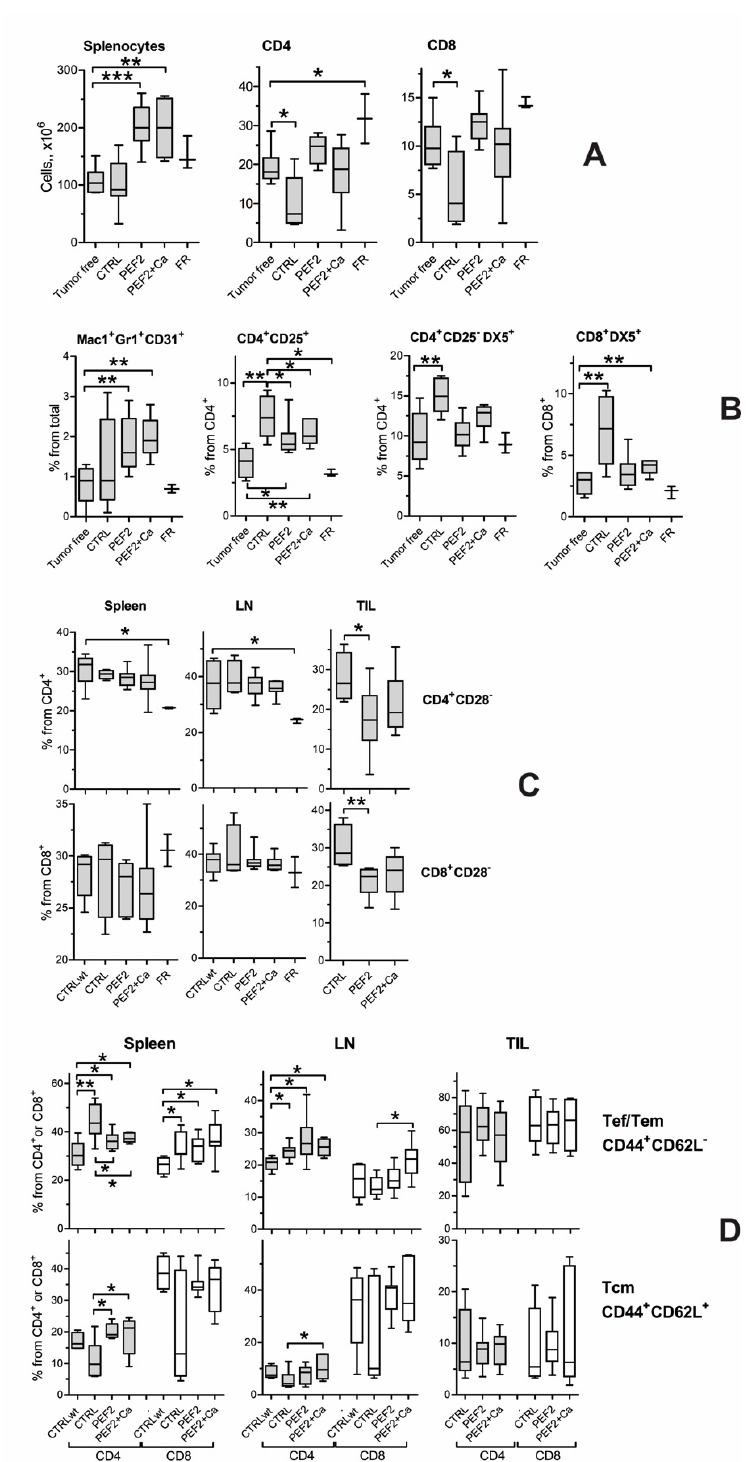
Figure 6. Lymphocyte subsets, where ( A ) the total numbers of splenocytes, CD4 and CD8 T cells in spleens; ( B ) percentages of myeloid suppressor Mac1 + Gr1 + CD31 + , CD4 + CD25 + and CD4 + CD25 − Dx5 + (Tr1) suppressor T cells, CD8 + DX5 + T cells in the spleens; ( C ) percentages of CD28-negative CD4 and CD8 T cells; ( D ) percentages of Tef/Tem (T effector memory cells) and Tcm (T central memory) cells. LN—lymph nodes, TIL—tumor infiltrated lymphocytes. Significant di ff erences between the mice groups according to Mann Whitney test are marked by asterisks: * p < 0.05, ** p < 0.005, *** p < 0.0005. Tumor-free mice ( n = 5–7), CRTL-tumor-bearing untreated or only CaCl 2 -treated mice ( n = 4–8), PEF2- treated mice ( n = 9), PEF2 and CaCl 2 -treated mice ( n = 7), FR-fully recovered mice ( n = 3).